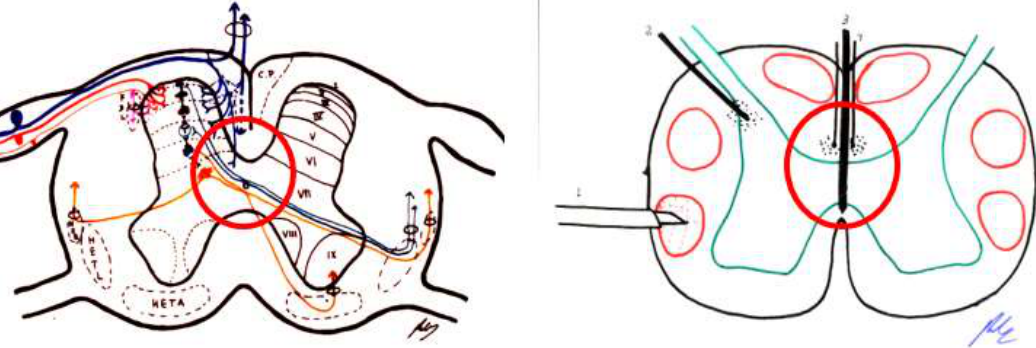
Figure 9. Myelotomy (see text). C.P. = P.C. (Posterior cord). HER = SRT (Spinoreticular tract). HETL = LSTT (Lateral spinothalamic tract). HETA = VSTT (Ventral spinothalamic tract). FDL = DLF (Dorsolateral fasciculus, Lissauer’s tract).